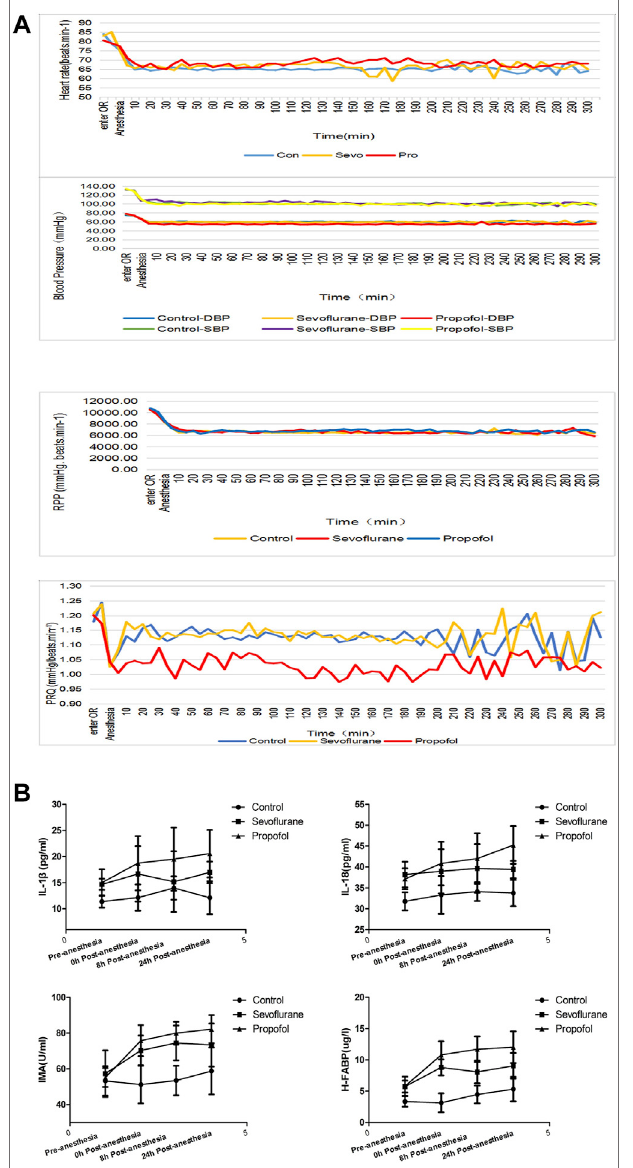
FIGURE 2 | Changes in vital signs and in fl ammatory factors in these three groups of patients . (A) different general anesthetics on the changes of heart rate, blood pressure, RPP and PRQ in peri-anesthesia in the three groups. (B) Changes of IL-18 at different time points at pre- and post- anesthesia.